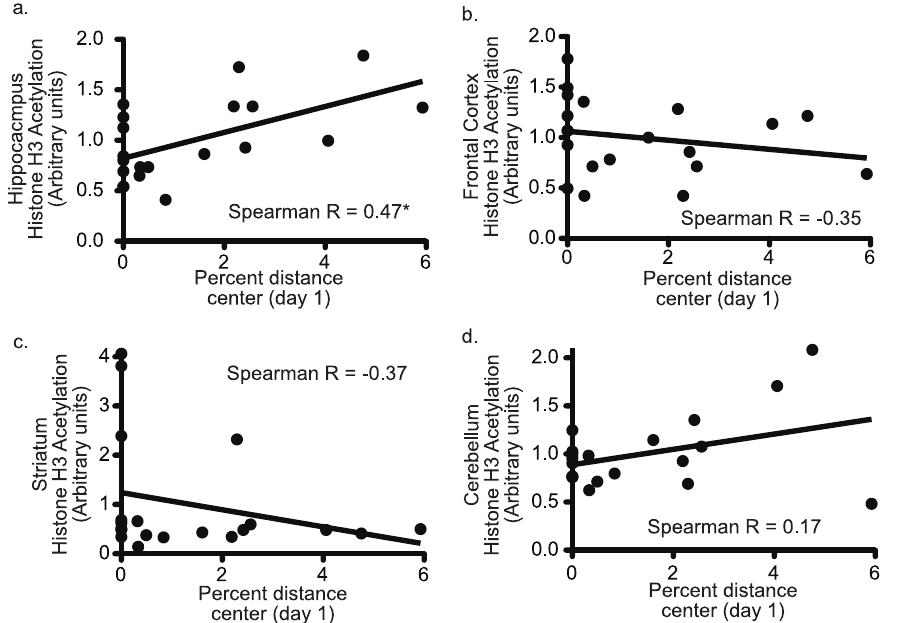
Figure 2. Levels of AcH3 in the hippocampus predict levels of open-field exploration. Figure shows bivariate plots of percent distance travelled in the center on day 1 (x-axis) versus AcH3 levels in various brain regions. There was a significant correlation between percent center and AcH3 in the hippocampus (panel a – Spearman r=0.47*) but not for other regions (panels b–d). Spearman r correlation values for other open-field measures are found in table S1.